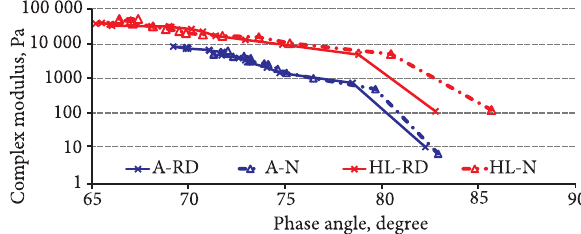
Fig. 5. Complex modulus G* versus phase angle of extracted bitumen from SMA pavement at the temperature of 60 °C